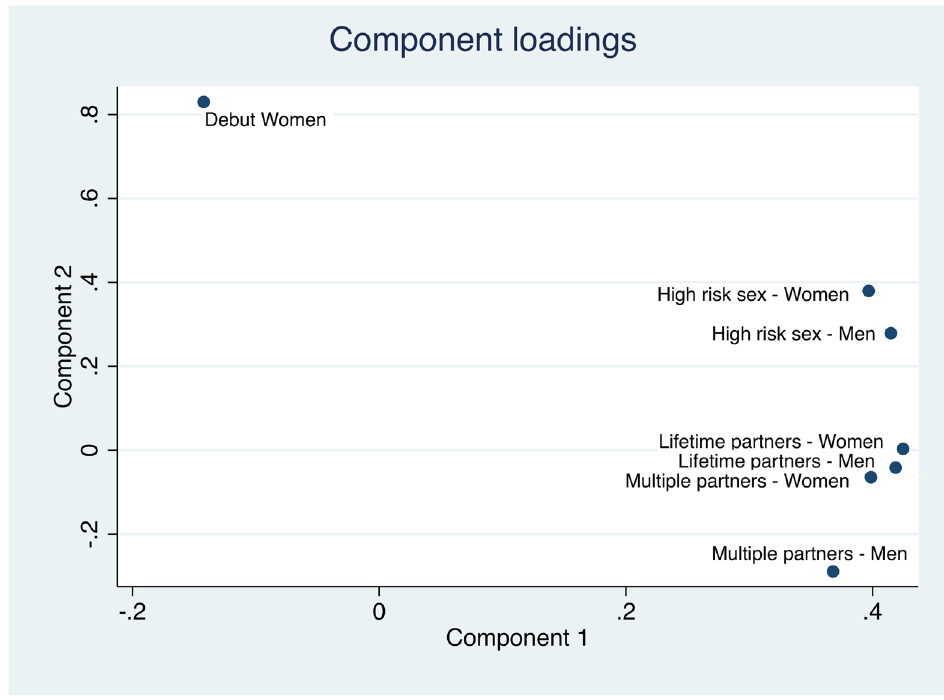
Figure 5. Loadings of the 7 behavioral risk factors in principal components 1 and 2.